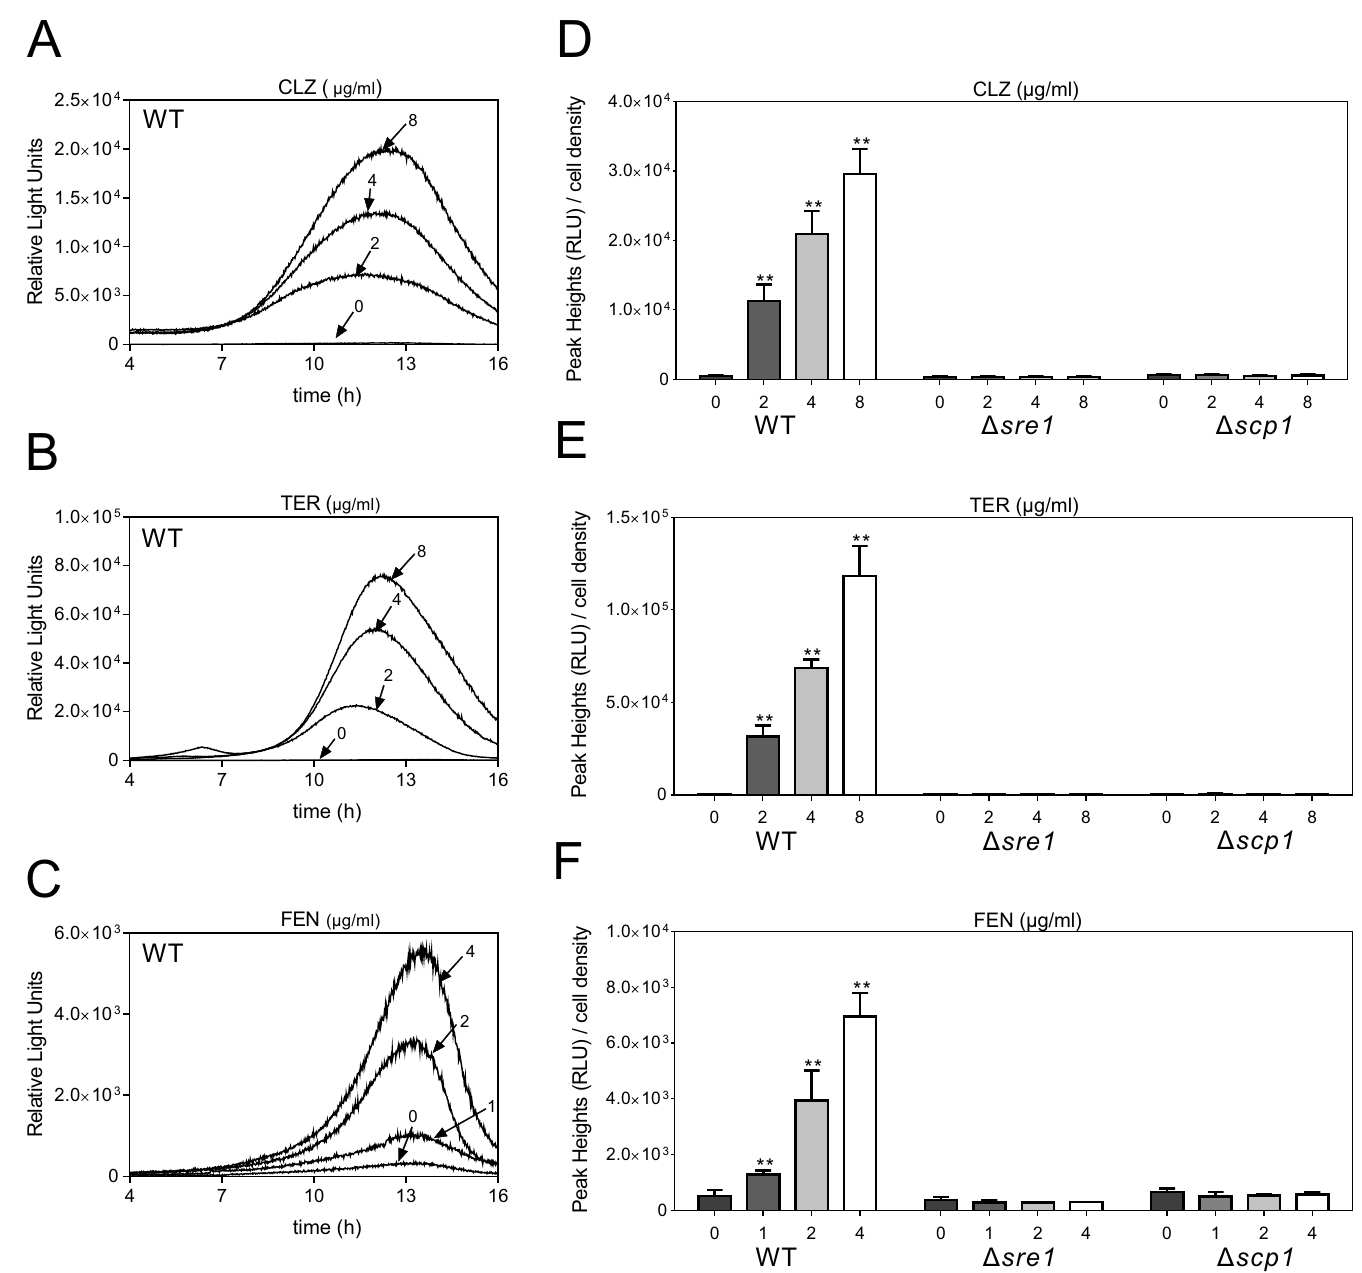
Fig 1. Real-time monitoring of Sre1 activity in living cells. (A) CLZ (2 μ g/ml to 8 μ g/ml), (B) TER (2 μ g/ml to 8 μ g/ml) and (C) FEN (1 μ g/ml to 4 μ g/ml) induced a marked increase in Sre1 transcriptional activity. Wild-type cells harboring the multicopy 3 × SRE2::luc (R2.2) reporter plasmid were cultured and assayed as described in materials and methods. Y-axis values are the relative light units (RLU) of each sample. The data shown are representative of multiple experiments. (D-F) CLZ (2 μ g/ml to 8 μ g/ml), TER (2 μ g/ml to 8 μ g/ml) and FEN (1 μ g/ml to 4 μ g/ml)-induced transcriptional activity was almost completely abolished in Δ sre1 and Δ scp1 cells. The Δ sre1 and Δ scp1 cells harboring the multicopy reporter plasmid were cultured and assayed as described in Fig 1A-1C. Y-axis values are the relative light units (RLU) of peak height normalized to cell density (OD660) of each sample at the peak time. The data were averaged from three independent experiments, and each sample was done in triplicate. Error bars indicate means (n = 3) ± S.D. �� P < 0.01 compared with the vehicle condition for the respective